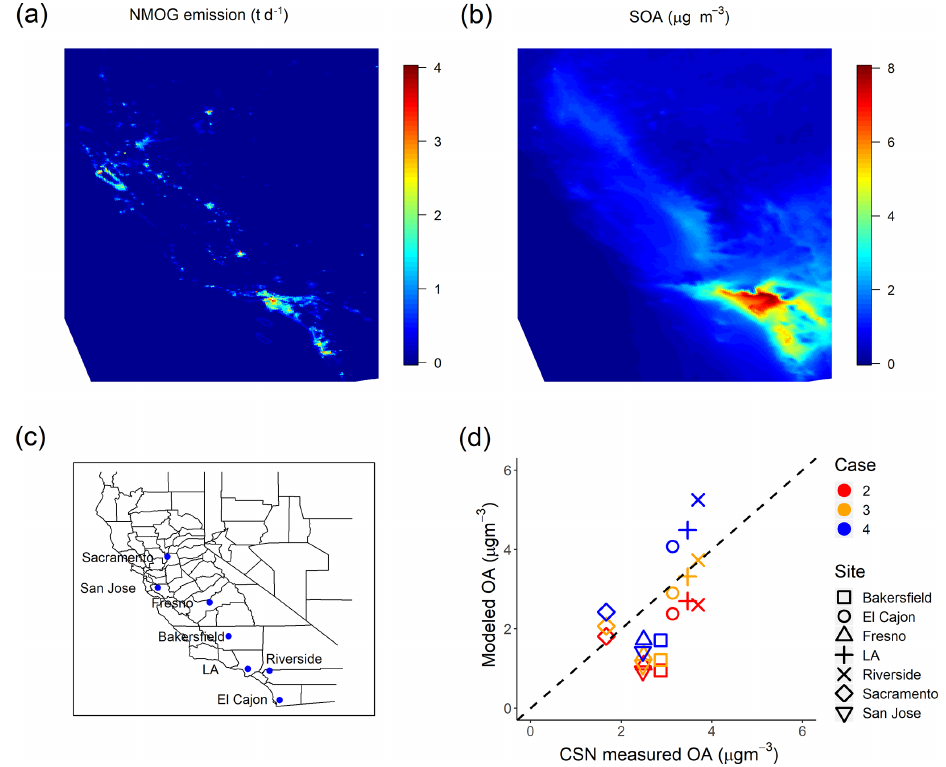
Figure 6. (a) Campaign-average NMOG emissions (td − 1 ) in the emission inventory. (b) Modeled campaign-averaged SOA concentration in Case 4. (c) Location of CSN sites used for model evaluation. (d) Comparison of modeled OA to measured OA (OC · 1 . 8) at CSN sites in